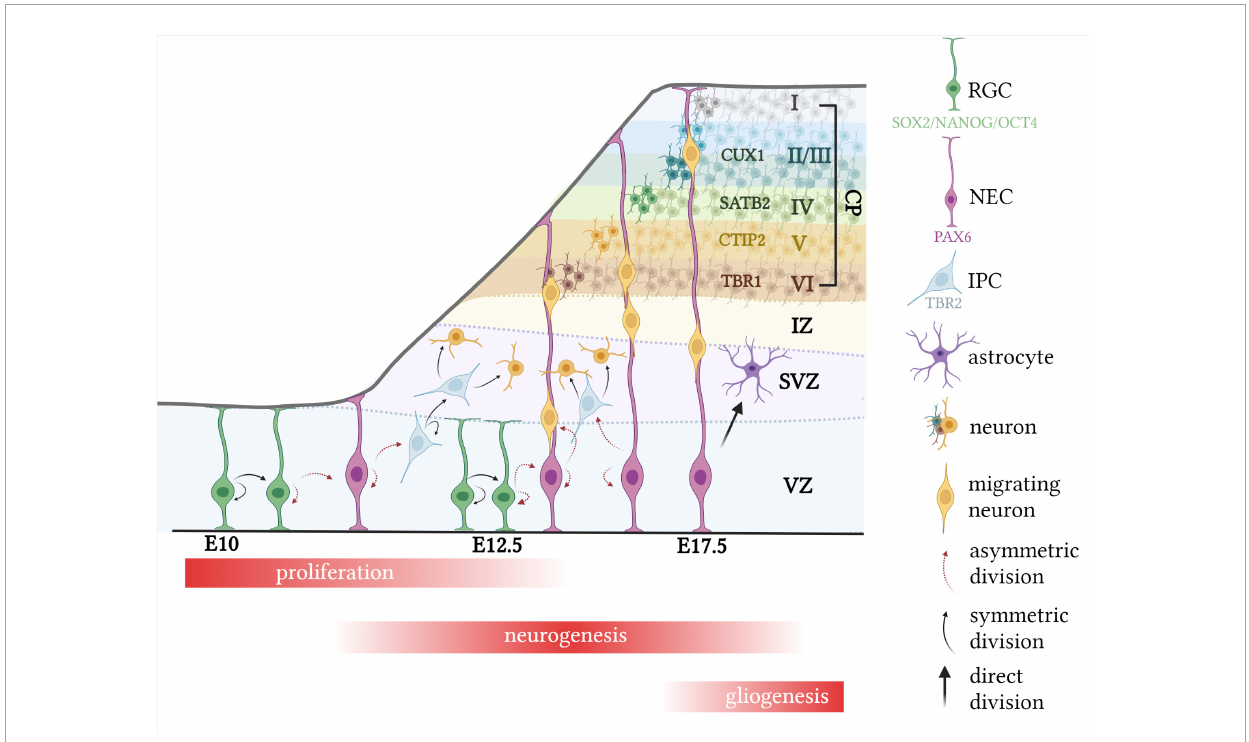
FIGURE1 Typical murine corticogenesis. Following expansion of the NEC pool, division of NECs begin to switch from symmetric to asymmetric, forming one RGC and one NEC. RGCs then divide either asymmetrically to generate two RGCs, or symmetrically to form one RGC and an IPC or neuron. IPCs divide only symmetrically to form a pair of IPCs or neurons. Migrating neurons use radial glial cells as scaffolds, to migrate up to the cortical plate, which expands in an “inside-out” manner, with the deep layer IV neurons forming first, at around E12.5. During late corticogenesis, RGCs begin to directly divide into glial cells, such as astrocytes. CP, cortical plate; CTIP2, COUP TF1-interacting protein 2; CUX1, cut like homeobox 1; E, embryonic day; SATB2, special AT-rich sequence-binding protein 2; SOX2, SRY-box 2; PAX6, paired box protein Pax-6; TBR1, T-box brain transcription factor; TBR2, T-box brain protein 2; IPC, intermediate progenitor cell; NANOG, nanog homeobox; NEC, neural epithelial cell. Created with